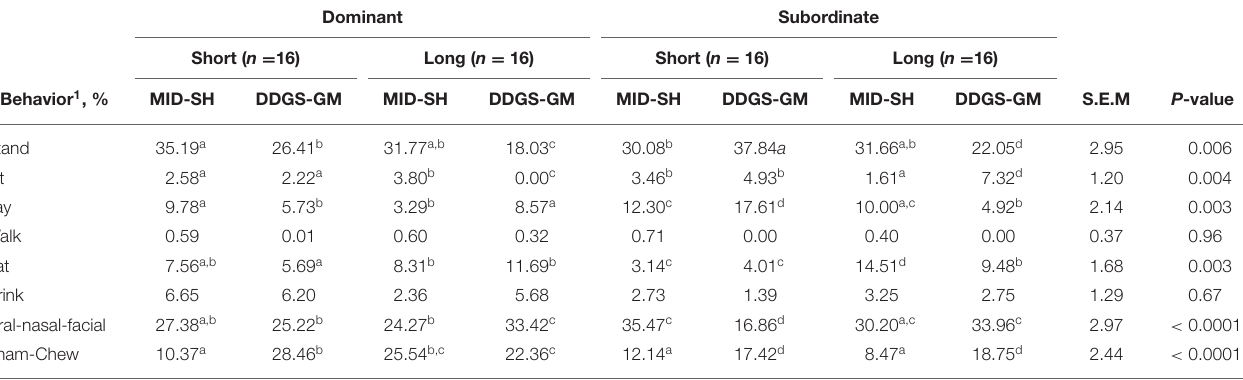
TABLE 4 | Interactive effects of social status on mean postural, maintenance, and oral behaviors for group-housed gestating sows fed one of two dietary fiber treatments and housed in pens equipped with short and long feeding barriers ( n = 64 total